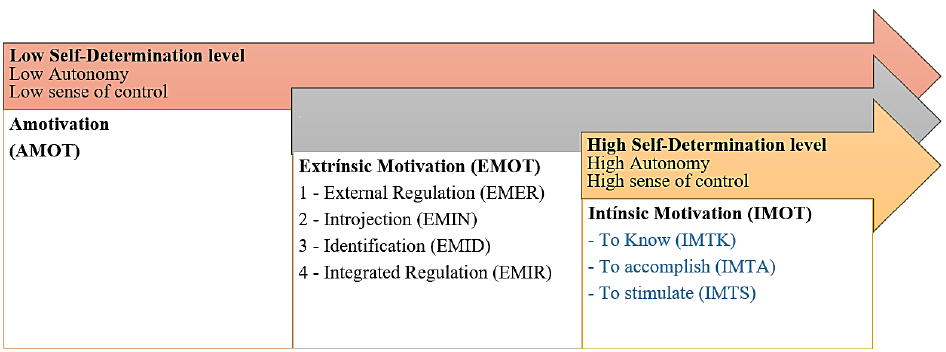
Figure 1. Self-determination continuum (adapted from Deci and Ryan [67] and Vallerand et al.